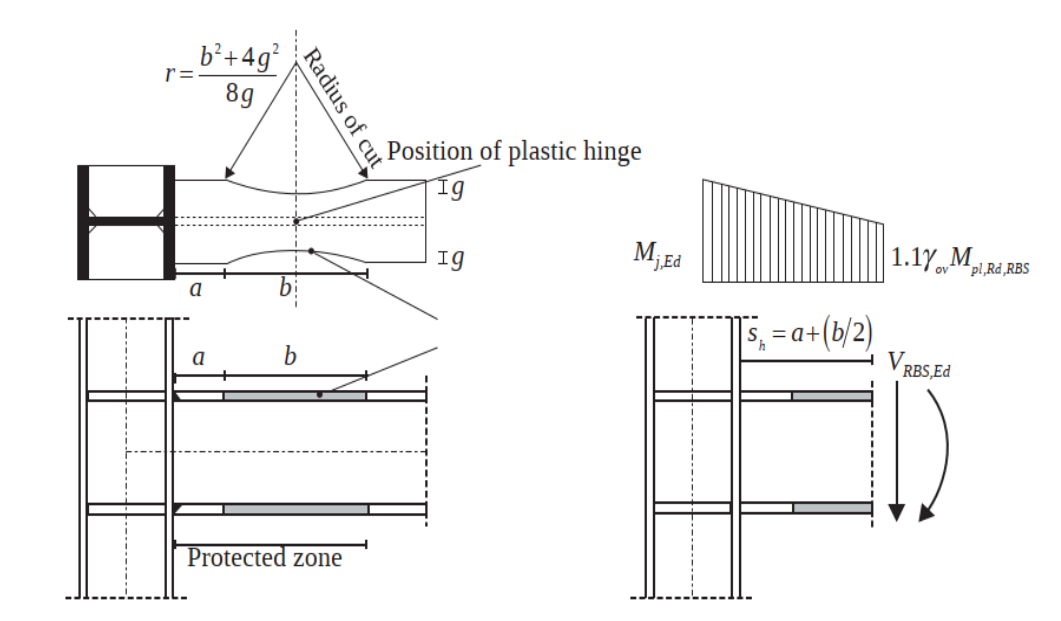
Fig. 5. Free body diagram of a welded RBS moment connection [16].